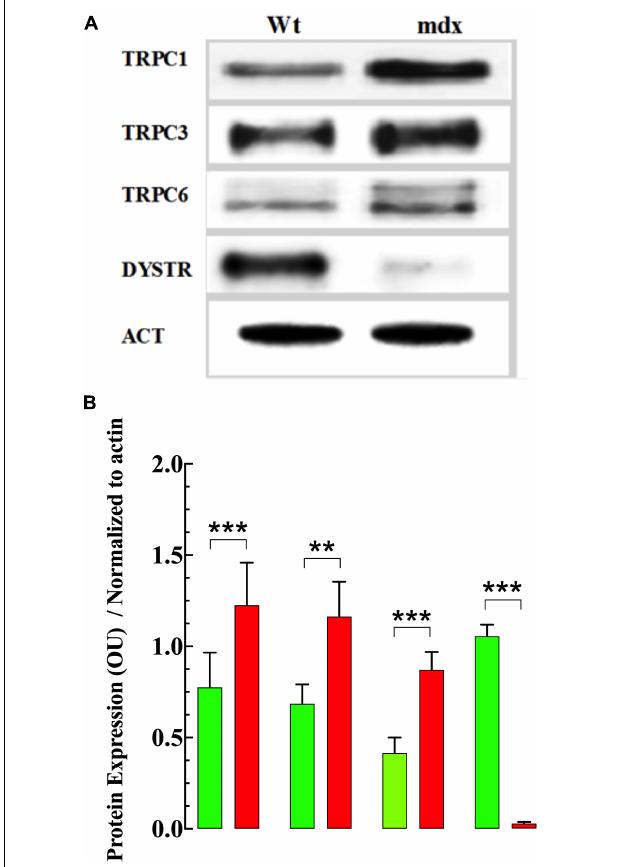
FIGURE 10 | Expression of TRPC isoforms. Figure 10 . Expression of TRPC isoforms. Representative fluorescent Western blot analysis of the expression of TRPC1, TRPC3, TRPC6, and dystrophin (DYSTR) proteins in Wt and mdx VSMCs (A) . Densitometric analysis of individual experiment fluorescent Western blots shown in (B) . Data were normalized to actin and expressed as mean optical unit values ± S.D. n mice = 3. Paired t -test, ** p ≤ 0.01, *** p ≤